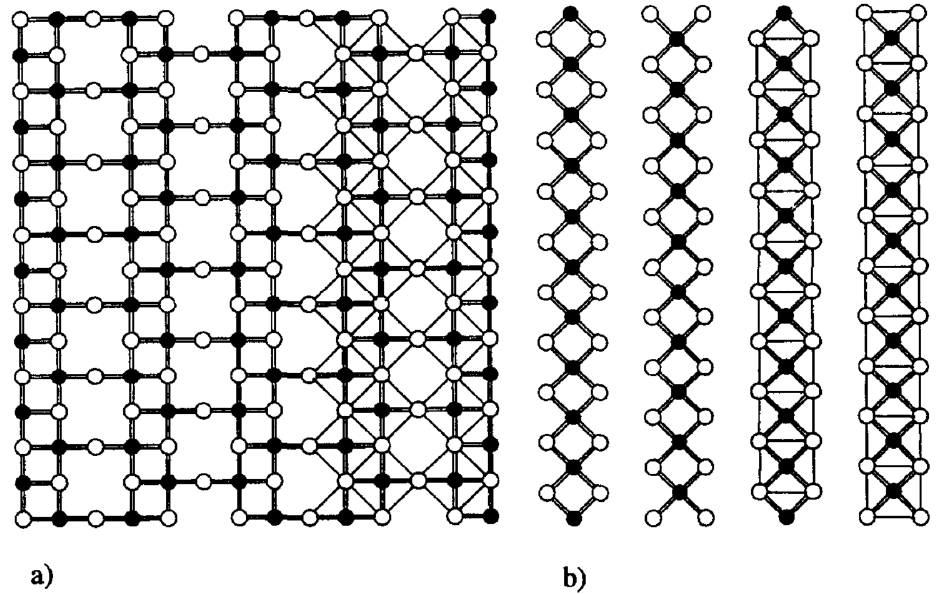
Figure 5. Two different Cu-O planes in the structure of Sr 14 Cu 24 O 41 : ( a ) two-leg ladder, ( b ) simple edge-sharing CuO 2 chains. Reproduced with permission from [70], Figure 1.